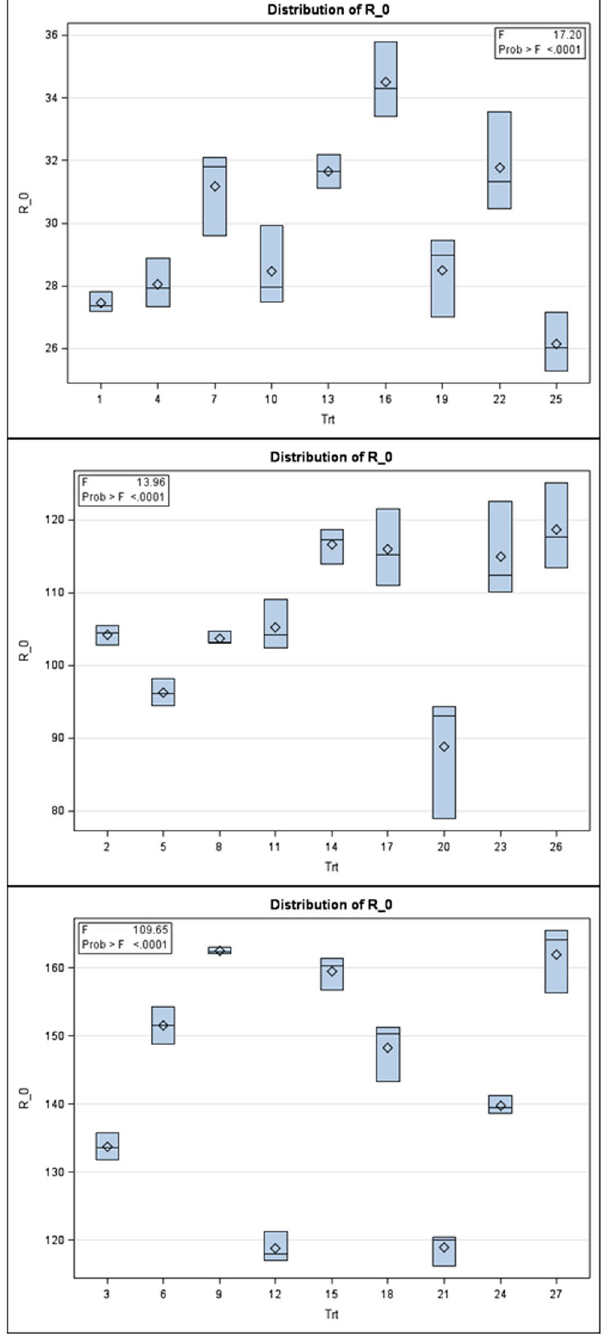
Figure 5. Univariate Box plot results following multivariate MANOVA for the fitness trait R 0 (labeled as R_0 in the figures) over the 3 levels of the N factor. Note the subtle pattern for the group means (in sets of 3 moving by eye from left to right) in each panel and among